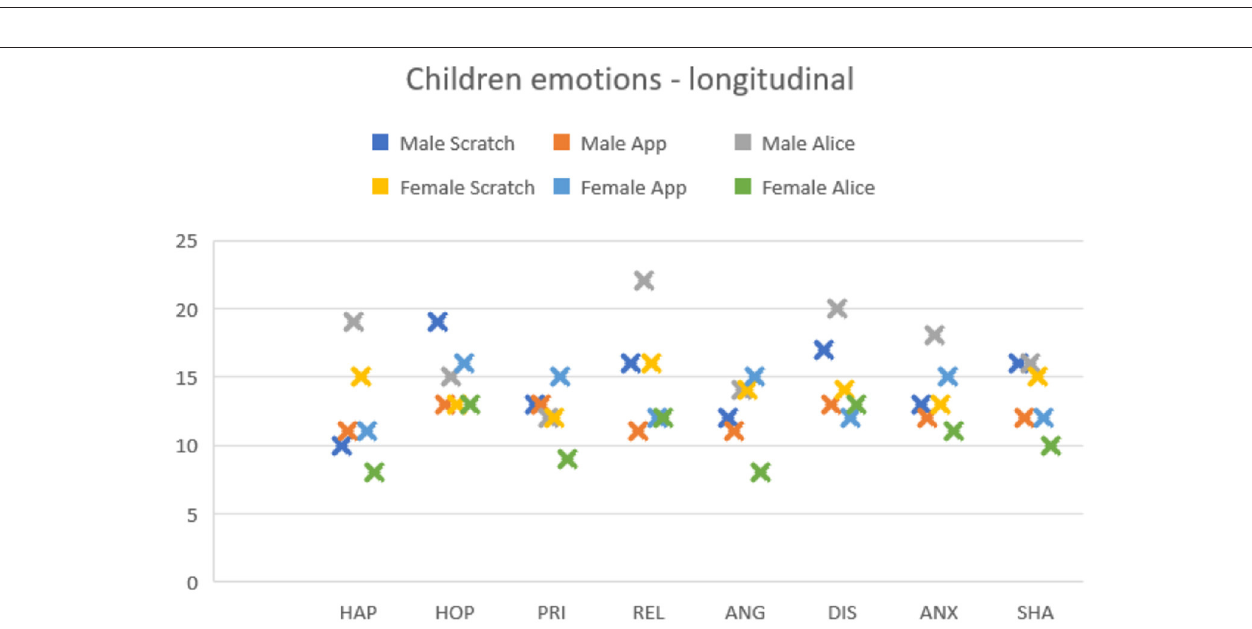
FIGURE 6 | Students’ emotions about the gaming workshops after one school year.